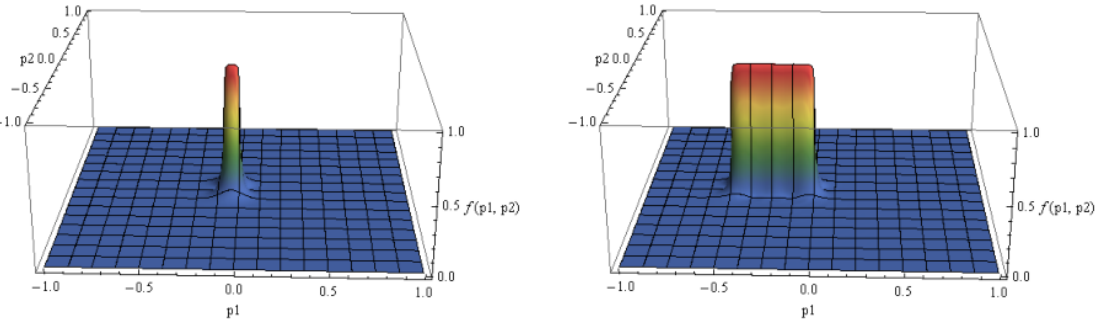
Figure 5. The distribution function in the constant electric field (57) with E a = 0.01 E 0 ( 1.088 × 10 6 V/cm) at t = 10 t 0 ( 2.46 × 10 − 15 s) after switching on the field ( left panel ) and at t = 50 t 0 ( 1.23 × 10 − 14 s) after switching on the field ( right panel ).